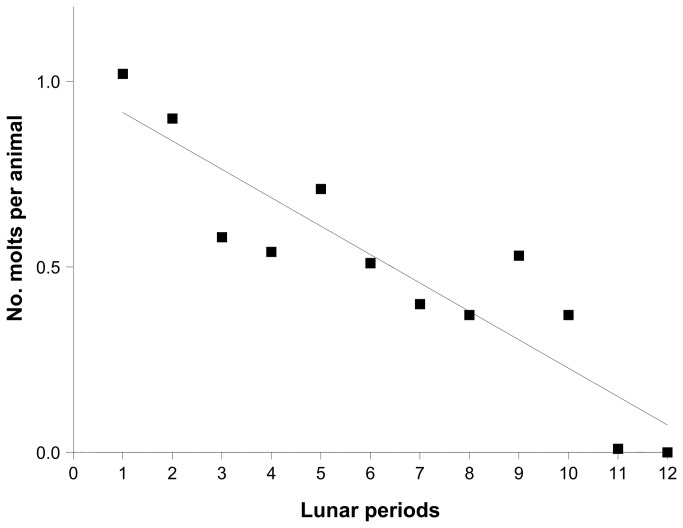
Number of molts per animal during the successive lunar cycles of the one-year experimental period (experiment 2).Linear regression line is shown.